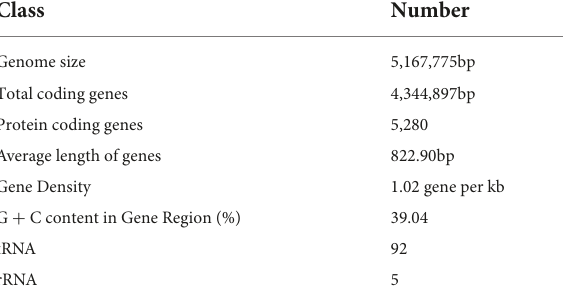
TABLE 1 Statistics of gene information of Bacillus aryabhattai